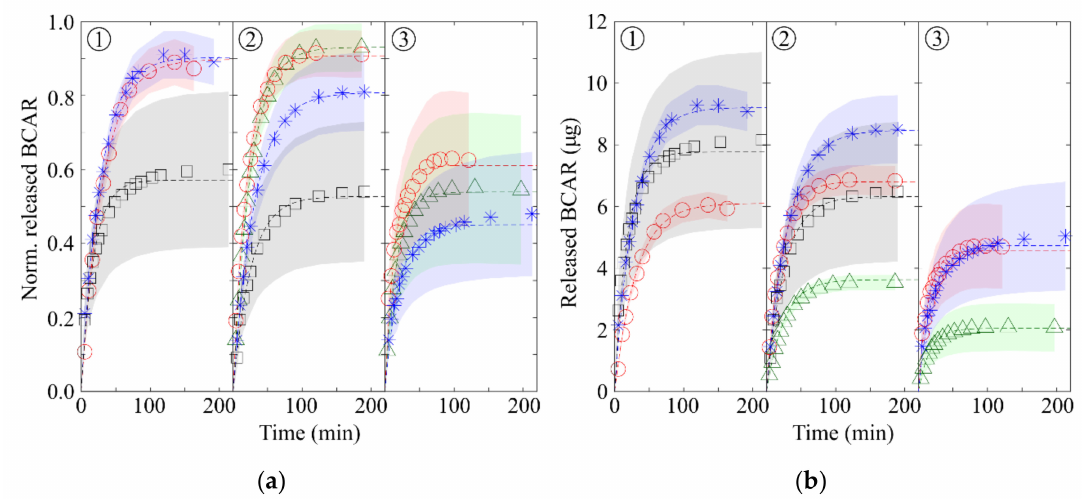
Figure 4. ( a ) Normalized BCAR release profiles from samples loaded with BCAR solutions of di ff erent concentrations. ( b ) Absolute release of BCAR from PSi samples. Concentration of loading solutions: (1) 0.17 mg / mL, (2) 0.3 mg / mL and (3) 1.5 mg / mL. Colors refer to the loaded BCAR amount: green triangles: ≈ 4 µ g, red circles: ≈ 7 µ g, blue asterisks: ≈ 10 µ g and black squares: ≈ 12 µ